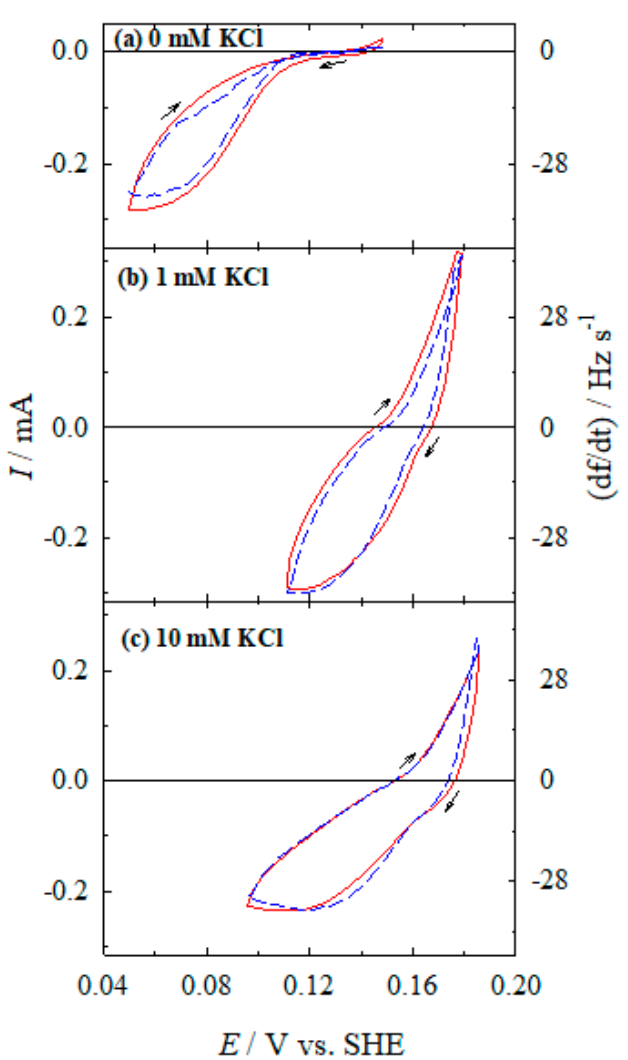
Figure 8. Dependences of the current (solid line) and the frequency change rate (dashed line) on the silver electrode potential. Solution composition (M): Ag 2 SO 4 —5 × 10 − 3 ; NH 3 —4.0; KCl: 0 ( a ), 10 − 3 ( b ), and 10 − 2 ( c ); pH 10.9; 20 °C. Potential sweep rate 2 mV s − 1 .